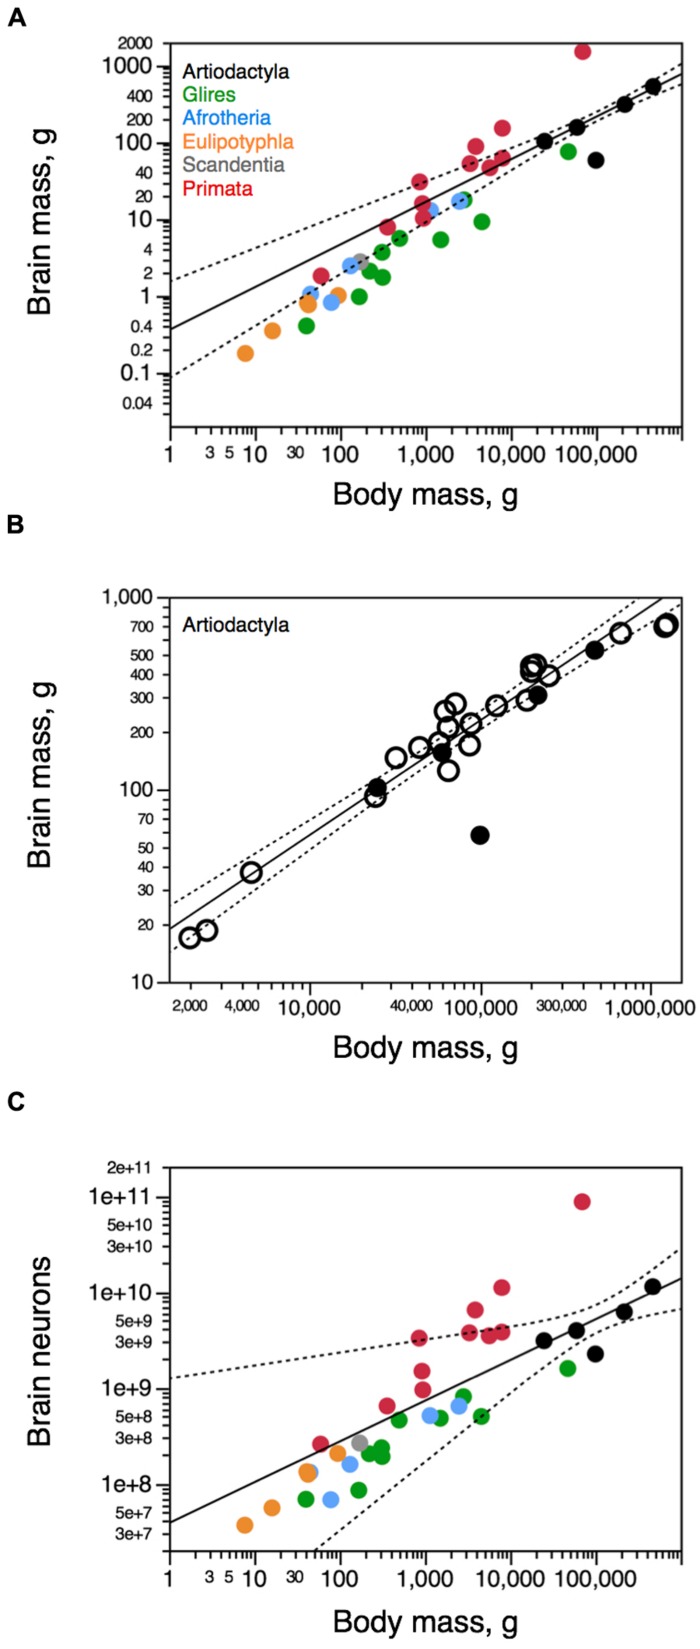
Artiodactyl brains gain mass with a different relationship to body mass compared to other mammals. Scaling relationships for artiodactyl brains (in black) are plotted along with rules found previously for other groups (primates in red, glires in green, afrotherians in blue, insectivores in orange, scandentia in gray). Graphs relate (A,B) total brain mass (excluding the olfactory bulb) and (C) total numbers of neurons in the brain (excluding the olfactory bulb) to body mass. (A,C) our dataset; (B) our dataset (filled circles), and dataset of Boddy et al. (2012; open circles). Each point represents the average values for each species. Only the power functions for Artiodactyla are plotted (excluding the pig), along with the 95% confidence interval (dotted line). Exponents are 0.555 ± 0.029 (A, brain mass × body mass), 0.596 ± 0.031 (B, brain mass × body mass, for the Boddy dataset exclusively), and 0.425 ± 0.069 (brain neurons × body mass). Data from Herculano-Houzel et al. (2006, 2007, 2011), Azevedo et al. (2009), Sarko et al. (2009), Gabi et al. (2010), and Neves et al. (2014).